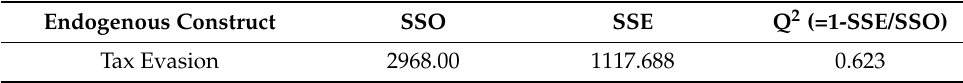
Table 7. Predictive relevance (Q 2